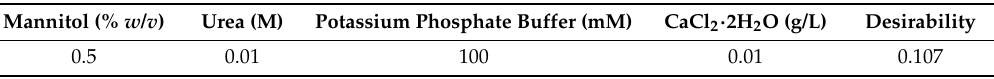
Table 9. Solution for simultaneous maximization of rhamnolipids production and Y P/S .